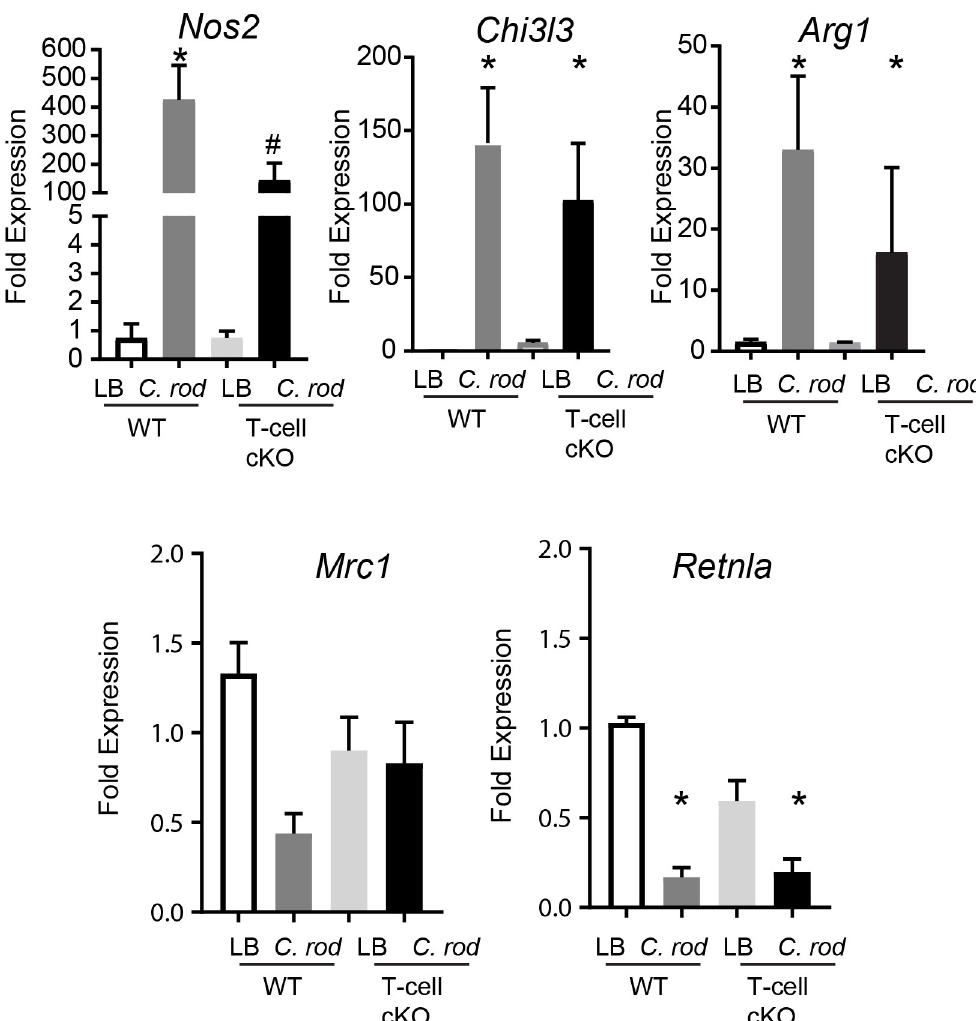
Fig 5. Loss of T-cell derived ACh reduces Nos2 expression during C. rodentium infection. Expression of genes characteristic of macrophage polarization were assessed by qRT-PCR on colonic tissue from LB or C. rodentium infected WT or ChAT T-cell cKO mice. � , # P < 0.05 ANOVA, with n = 8–10 mice per group.